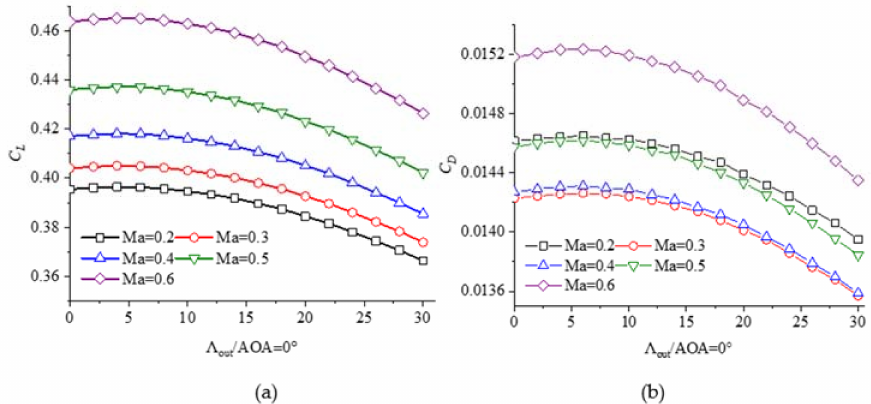
Figure 8. Aerodynamic coefficient changes with the configuration of Model2 at different Mach numbers with the sweep angle change in outer section under the coordinate morphing mode when AOA = 0 ◦ . ( a ) Lift coefficient, ( b ) drag